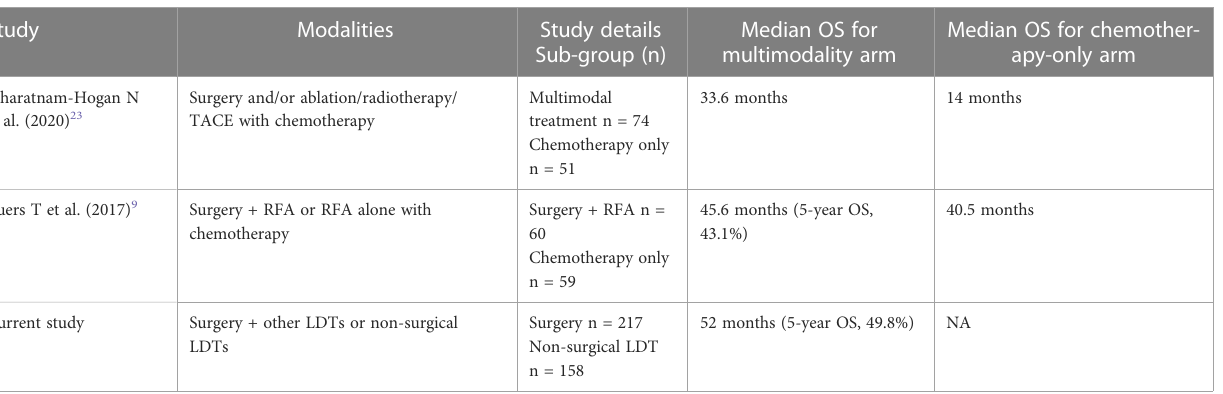
TABLE 4 Multimodality treatment of CRLM.